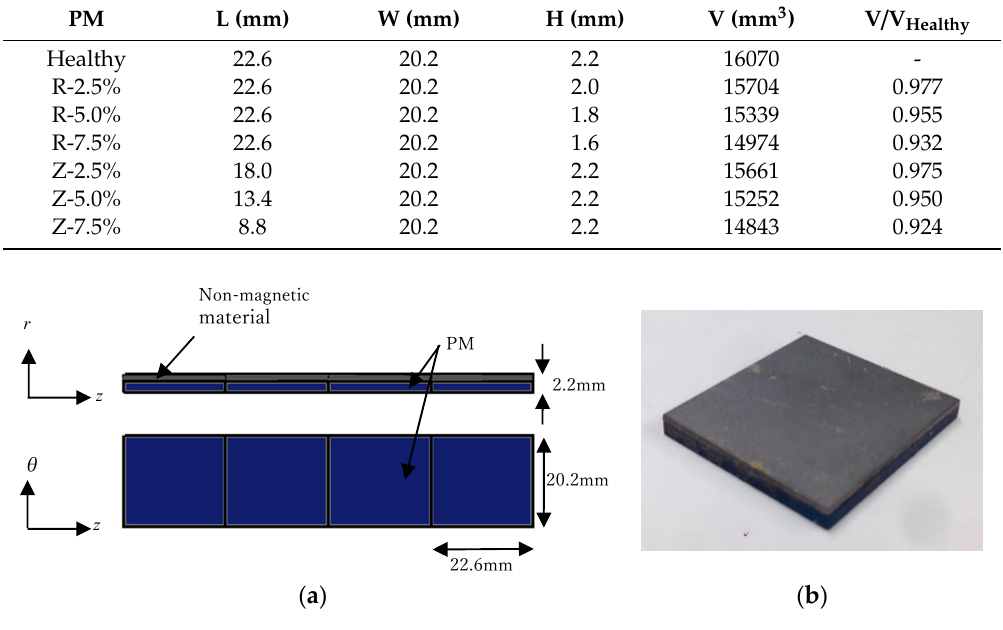
Figure 2. PMs for radial demagnetization: ( a ) magnet configuration; ( b ) photograph of magnet.